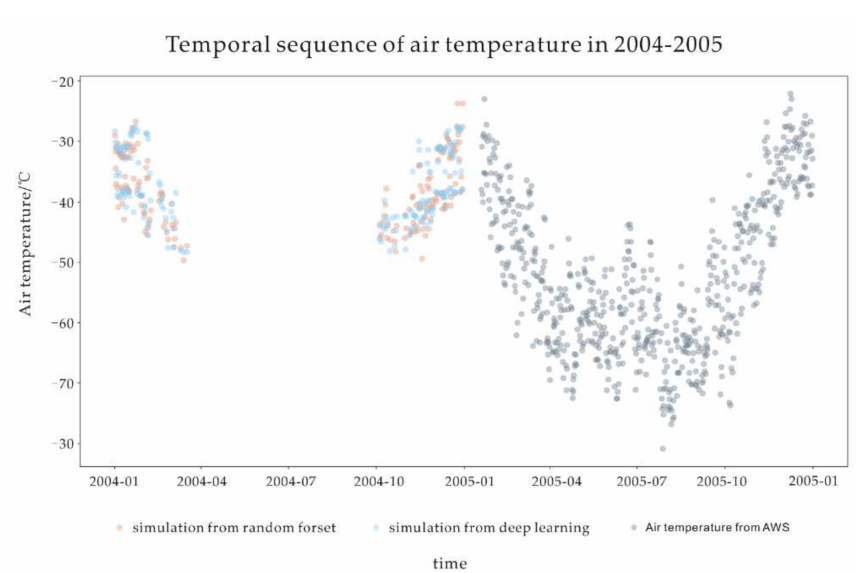
Figure 10. Simulated time series data using random forest and deep